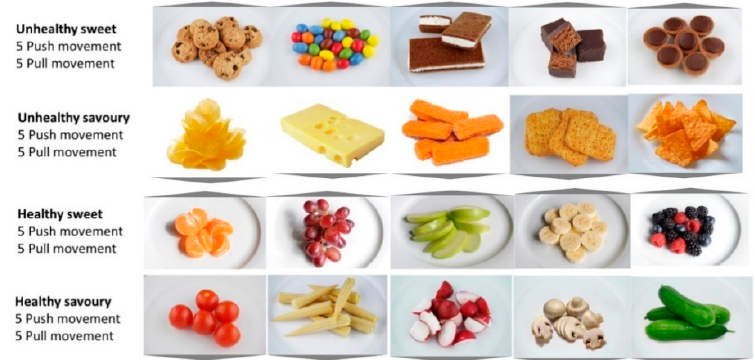
Figure 2. Examples of target images from the stimuli set used in the Approach-Avoidance Procedure.